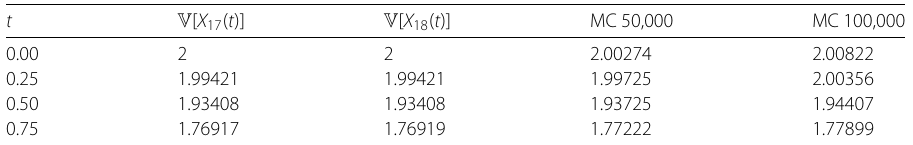
Table 13 Approximation of the variance of the solution stochastic process. Example 4.4, assuming independent initial